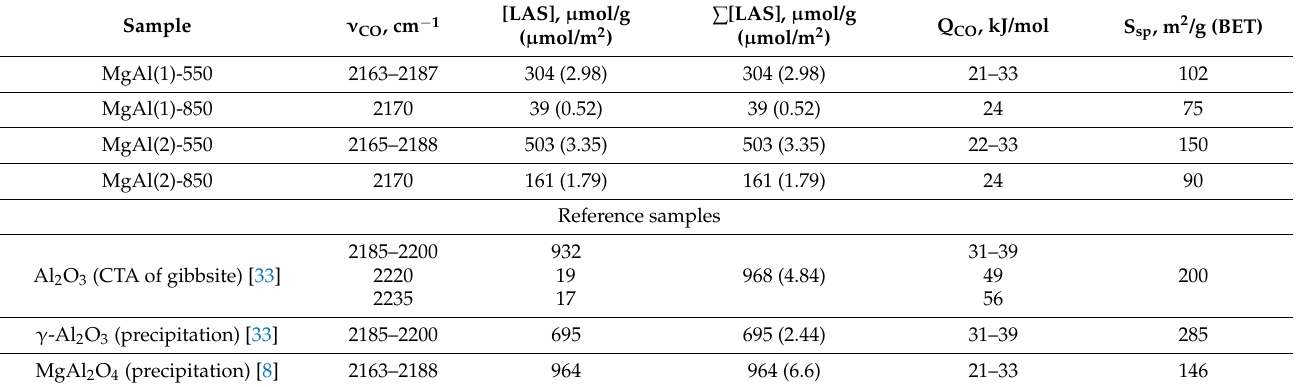
Table 2. Characteristics of Lewis acid sites revealed by IR spectroscopy of adsorbed